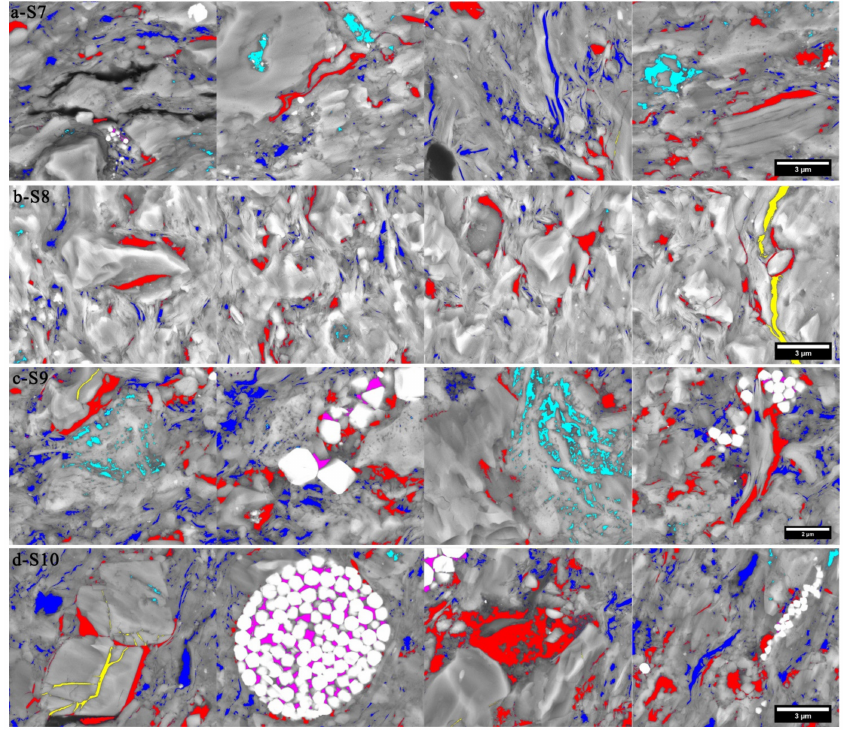
Figure 12. Pore identification in calcareous shales: ( a ) S7; ( b ) S8; ( c ) S9; ( d ) S10. Red represents interparticle pores, blue represents intraparticle pores, cyan represents dissolution pores, magenta represents intercrystal pores in the pyrite aggregates and yellow represents